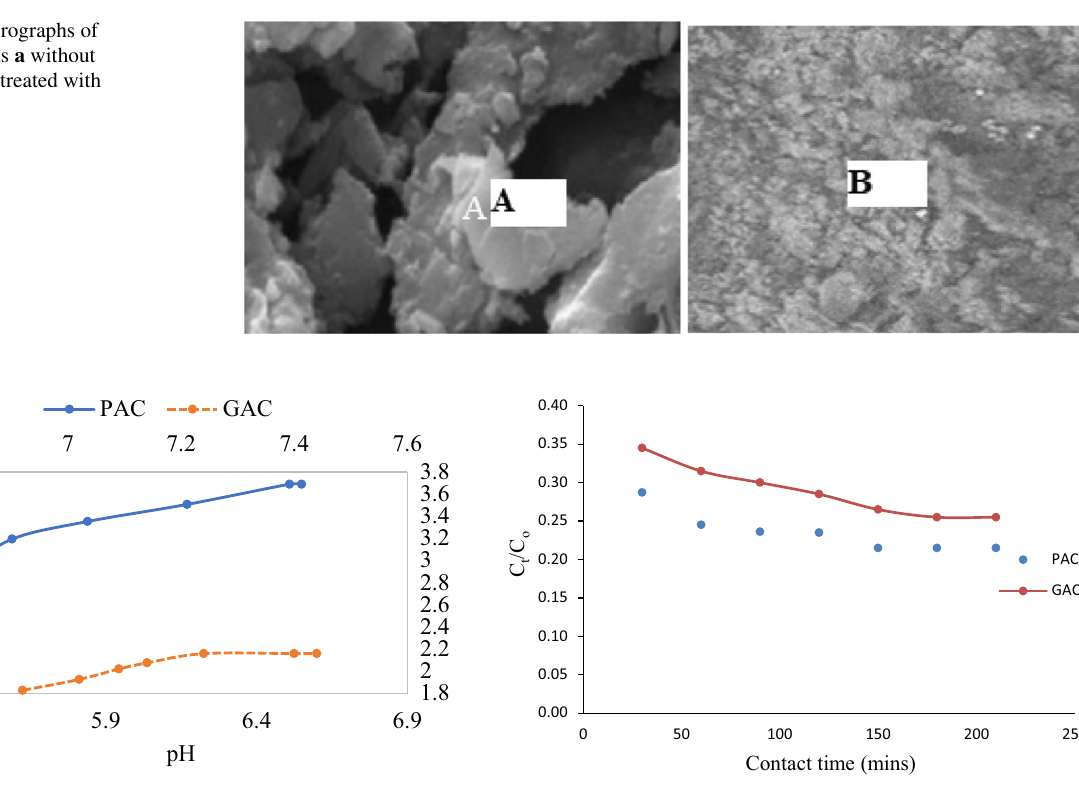
Fig. 3 Plot of lg Kd versus final pH for proton coefficient for PAC and GAC